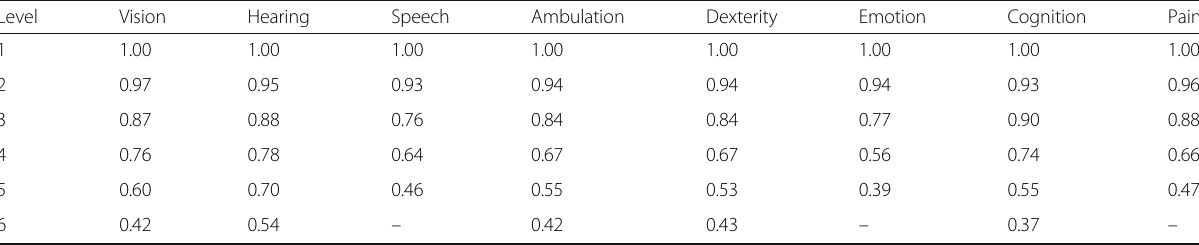
Table 4 Multi-attribute utility function for Japanese HUI3